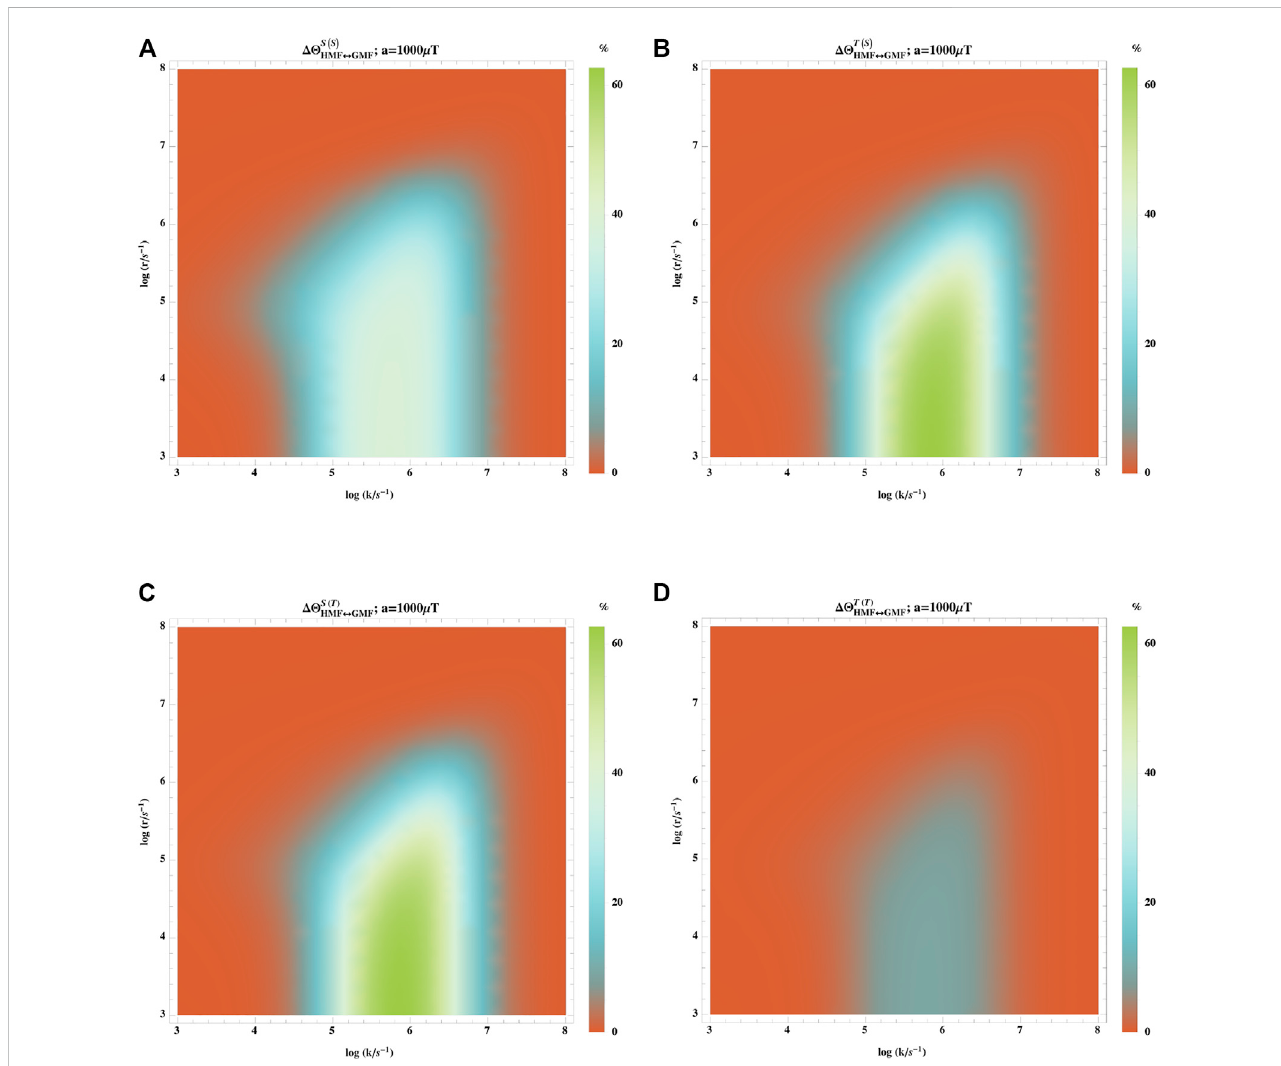
FIGURE 6 Impact of the initial state of the radical pairs (singlet or triplet) on the hypomagnetic fi eld effects. The hypomagnetic fi eld effect is based on the singlet yield ratio with initial singlet states (A) , the triplet yield ratio with initial singlet states (B) , the singlet yield ratio with initial triplet states (C) , and the triplet yield ratiowithinitialtripletstates (D) .Inthismodel,oneoftheradicalshasnohyper fi neinteraction,andtheotheroneiscoupledtoanisotropichyper fi necoupling constantof a eiso =1,000 μ T.Theeffectisevidentwhen k ∈ [10 5 – 10 7 ] s − 1 and r < 10 6 s − 1 .However,theeffectismorepronouncedwhenisbasedonsinglet (triplet) yield with triplet (singlet) initial states, Φ S ( T ) ( Φ T ( S )